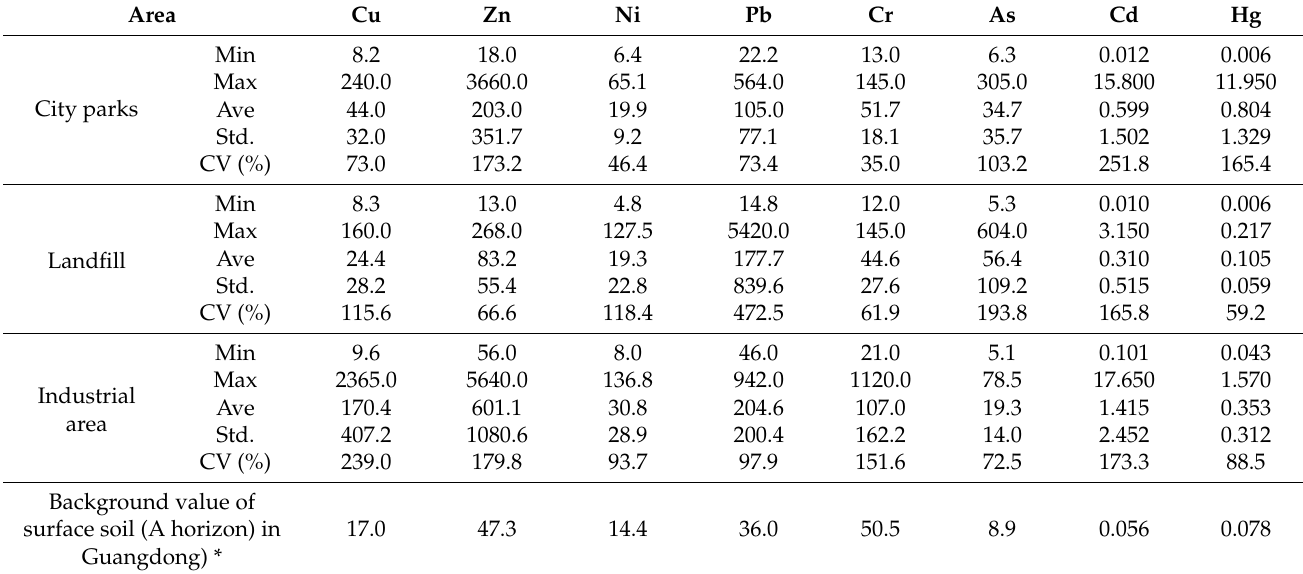
Table 3. Statistical summary of heavy metal contents (unit: